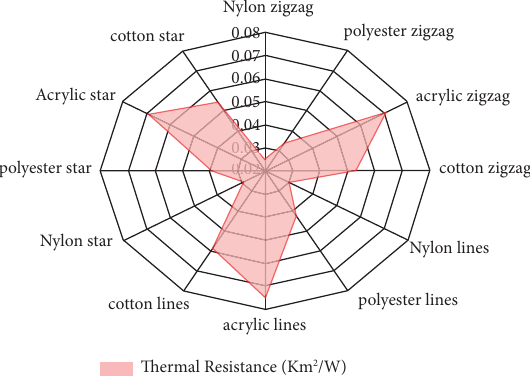
Figure 22: thermal resistance of auxetic fabrics.